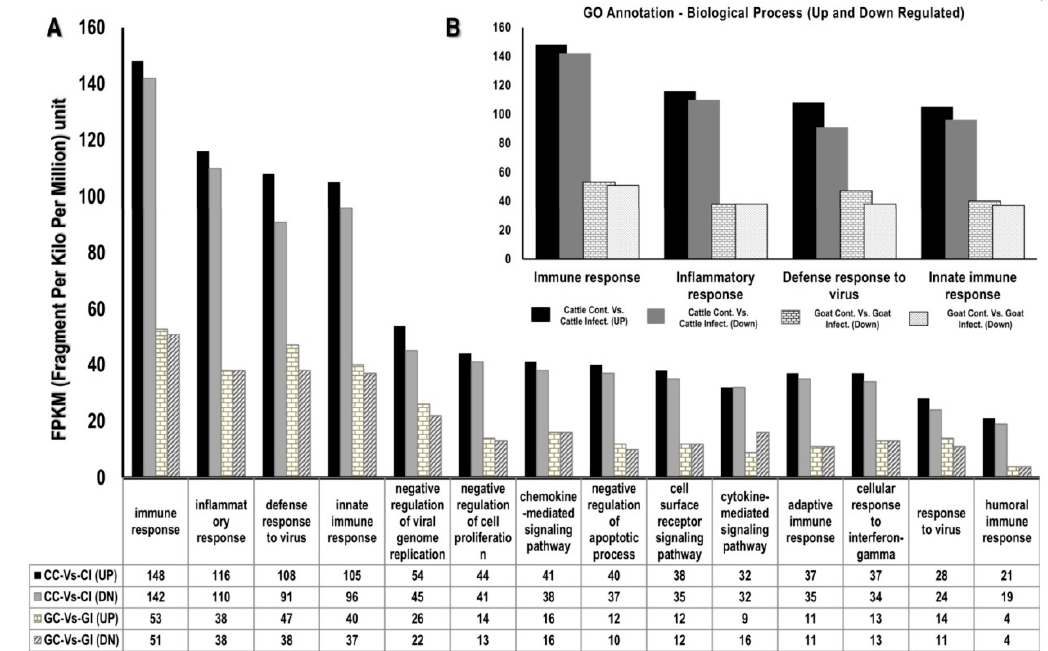
Figure 3. Gene ontology of the di ff erentially expressed transcripts upon PPRV infection in goat and cattle PBMC. The gene ontology (GO) analysis was carried out for all the di ff erentially expressed transcripts against all biological processes with a p -value ≤ 0.05. ( A , B ) The figure depicts the transcripts in FPKM for some of the selected sub-categories under the biological process (based on our previous report [17]) targeted in the study for further analysis to determine di ff erential expression across goats and cattle upon exposure to PPRV.